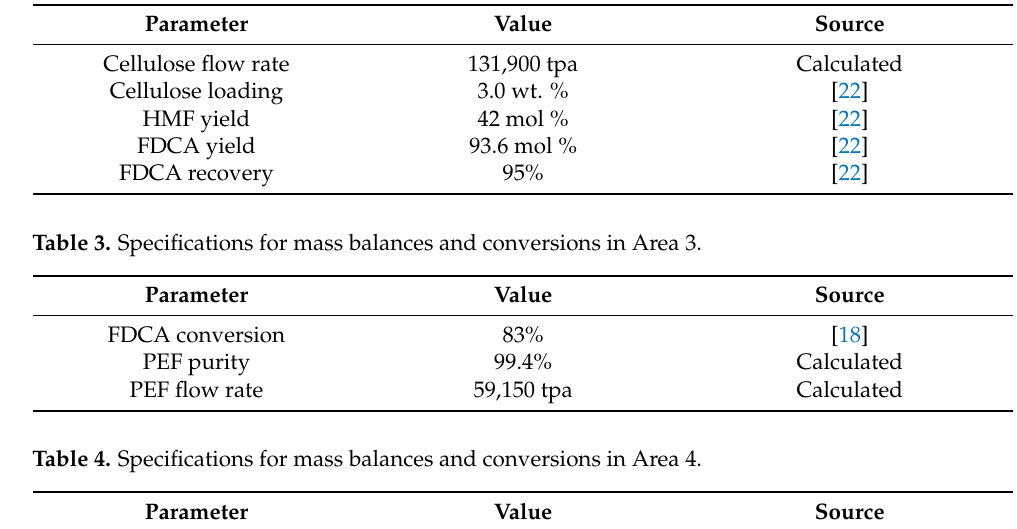
Table 2. Specifications for mass balances and conversions in Area 2.